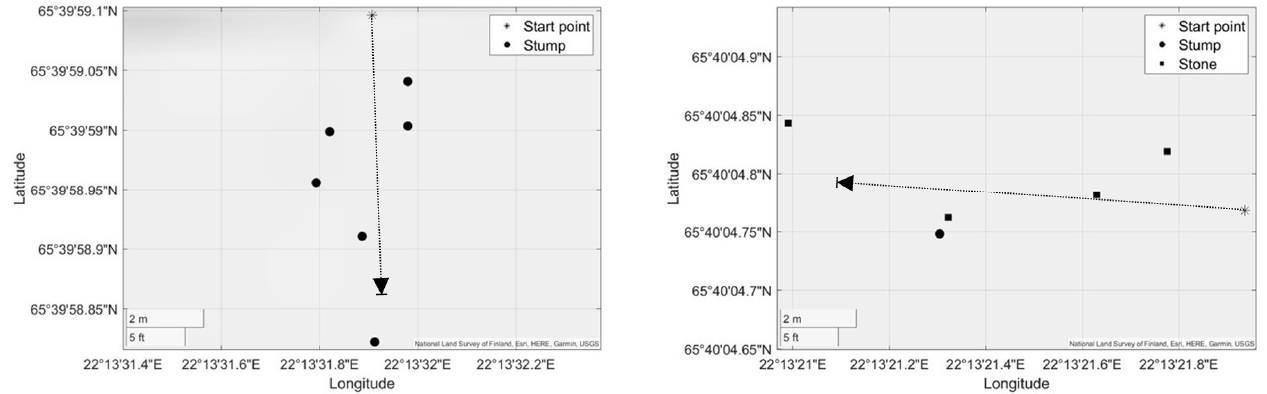
Figure 3. Trajectories of Track 1 (left pane) and Track 2 (right pane) with positions of the target objects.